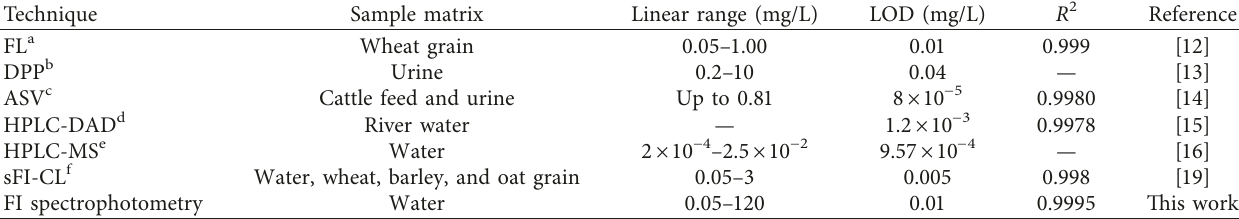
Table 2: Comparison of analytical characteristics of the proposed method with other methods used for the analysis of ANTU.